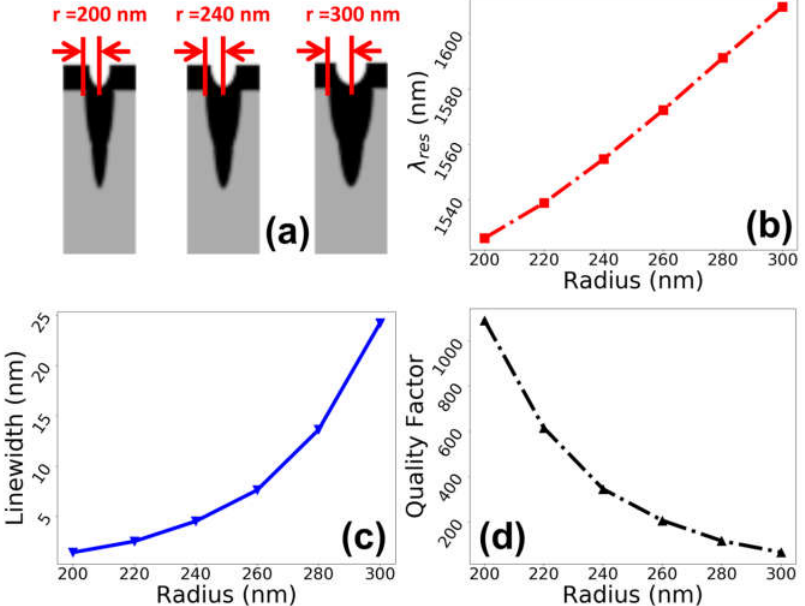
Figure 5. ( a ) Cross-sectional view of the simulation model with hole-radius values of r = 200, 240 and 300 nm. ( b ) λ res vs. hole-radius. ( c ) Linewidth vs. hole-radius. ( d ) QF vs. hole-radius.